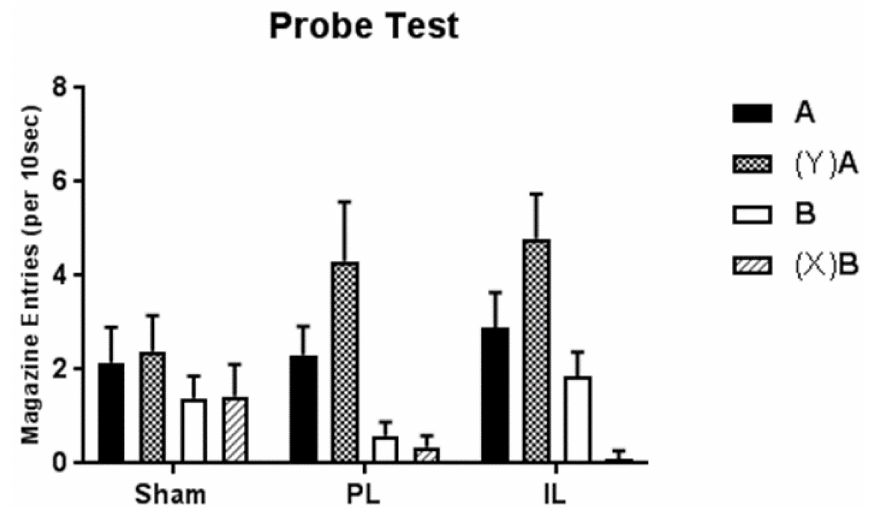
Figure 4. Rate (per 10 s; relative to baseline) of magazine entry during presentation of the target cue on feature-present ((Y)A and (X)B) and feature-absent (A+ and B − ) trials of the probe test. Note paired features are the reverse of those in training. Error bars represent